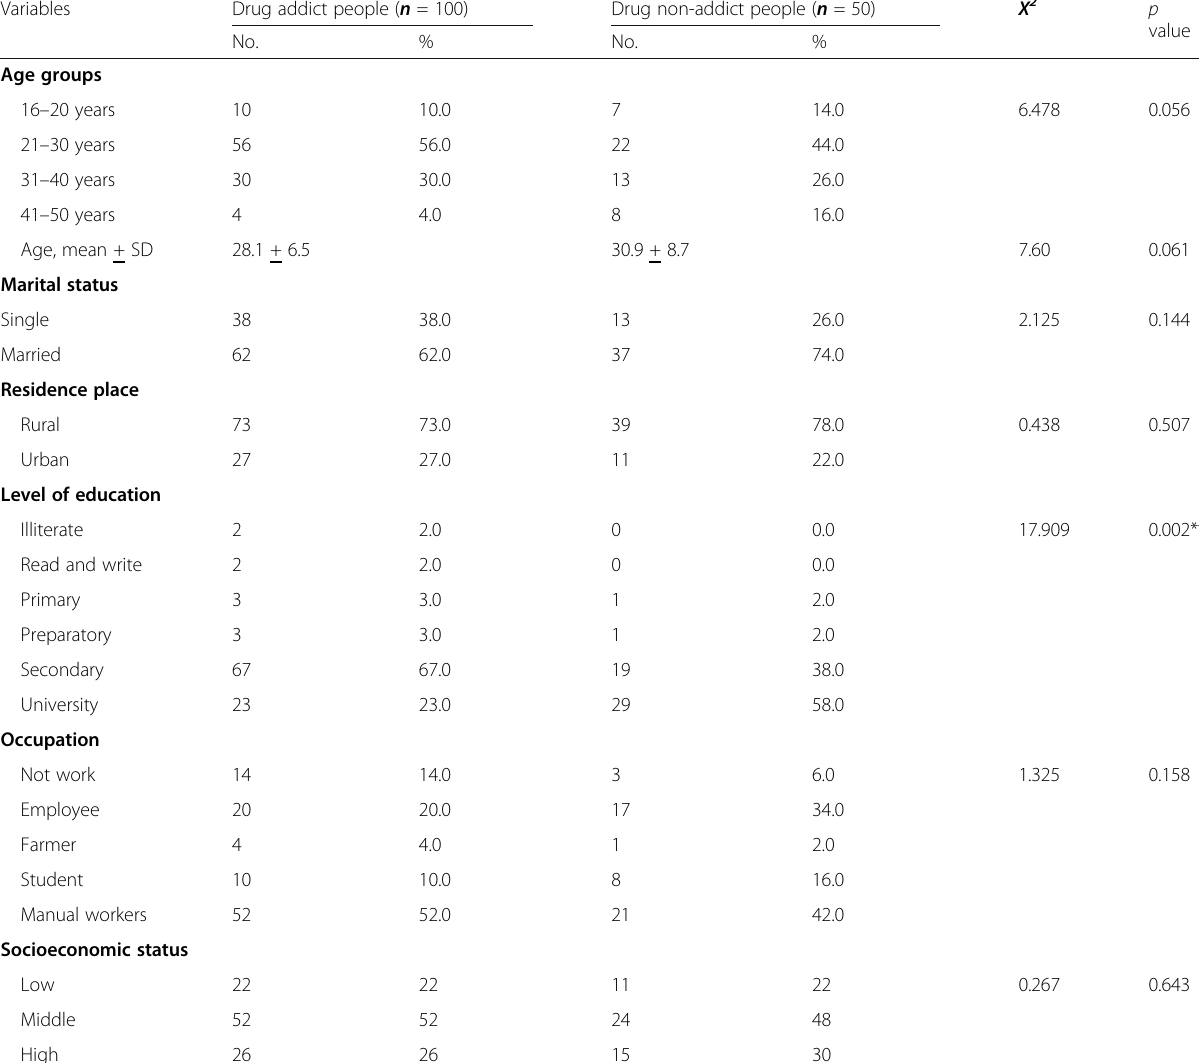
Table 1 Comparison between the SUD patients ( n = 100) and the control group ( n = 50) regarding socio-demographic data